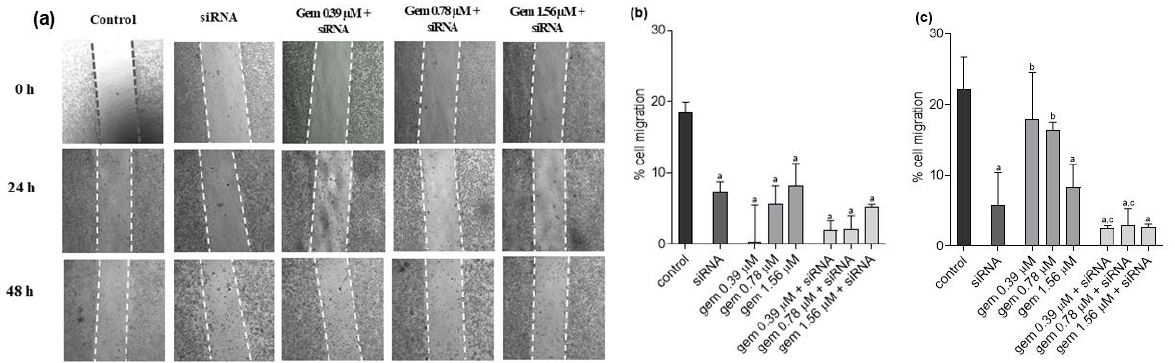
Figure 8. Photographs ( a ) and quantification ( b , c ) of cell migration in UM-UC-3 cells after treatment with gemcitabine, siRNA JHDM1D-AS1 , or gemcitabine combined with siRNA JHDM1D-AS1 . Con- trol: untreated cells; gem: gemcitabine. a: p < 0.05 compared to control; b: p < 0.05 compared to siRNA; c: p < 0.05 compared to respective gemcitabine concentration alone.